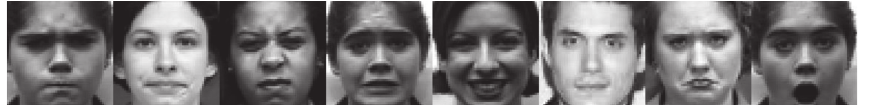
Figure 1: Basic facial expression phenotypes from CK+ and FER2013: from left to right are anger, contempt, disgust, fear, happiness, neutral, sadness, and surprise.